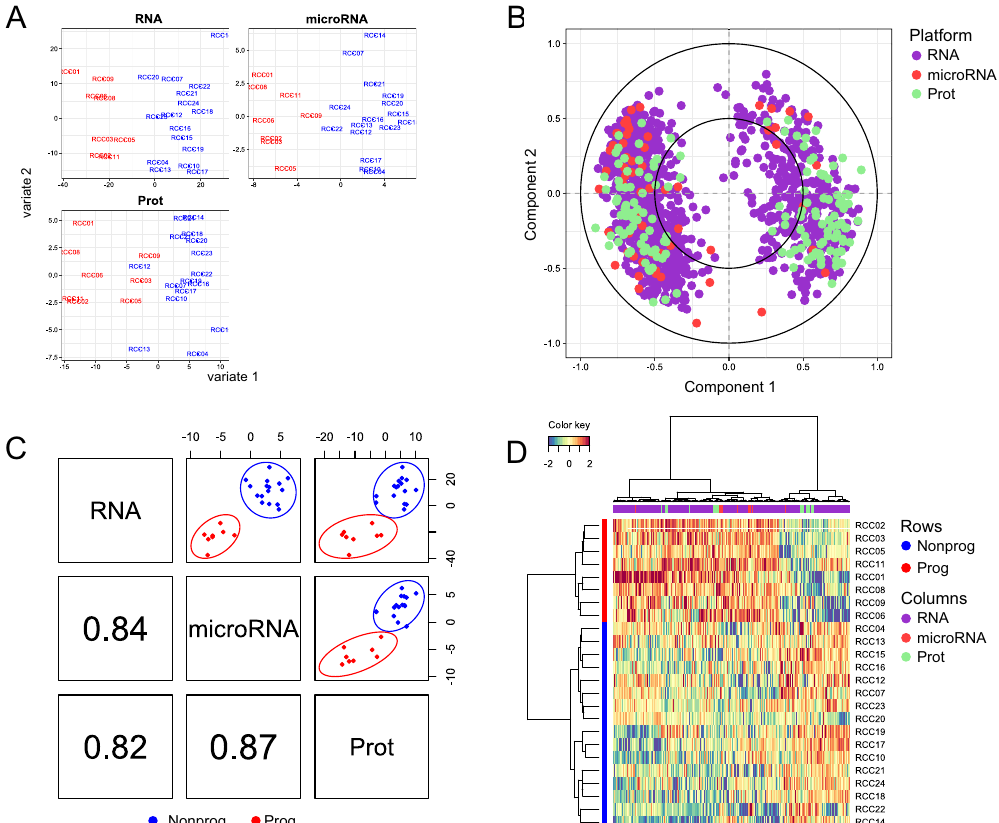
Figure 3. Multiomics integration. Sparse PLS-DA (sPLS-DA) for RNA, miRNA and protein datasets with respective differentially expressed features support the expected separation of sample groups on the first component ( A ). The correlation circle plot ( B ) displays the correlation between variables (biological features) and latent components. Each variable coordinate is defined as the Pearson correlation between the original data and a latent component 58 . The contribution to the definition of each component is visualized as closeness to the circle with radius 1, as well as the correlation structure between variables (clusters of variables). The cosine angle between any two points represents the correlation (negative, positive or null) between two variables. A global overview of the correlation structure for component 1 is shown in ( C ). A strong correlation is detectable for each dataset combination, the strongest being for the combination RNA/microRNA. ( D ) Clustered Image Map (CIM) showing two clusters of samples (rows) and two main clusters of over- and underrepresented features from all three data sources. CIM is based on a hierarchical clustering simultaneously operating on the rows and columns of the selected variables in the original data, here reported by using Euclidian distance and complete